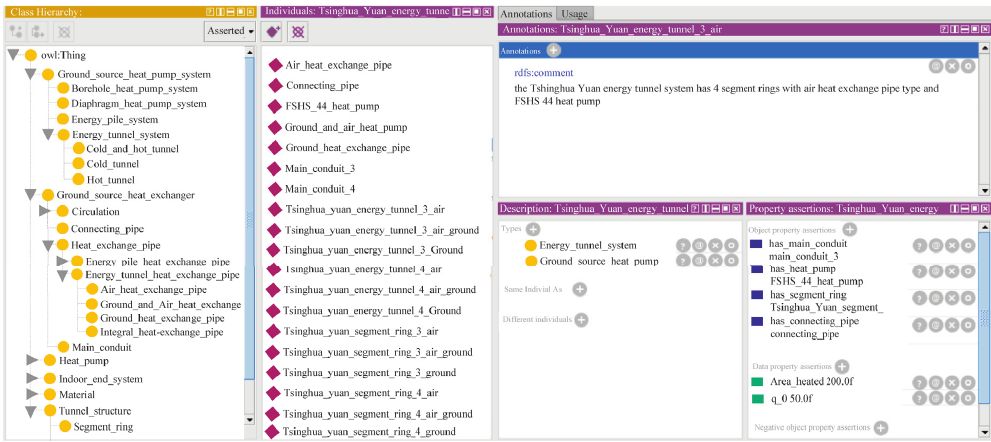
Figure 5: Development of an instance of the energy-tunnel